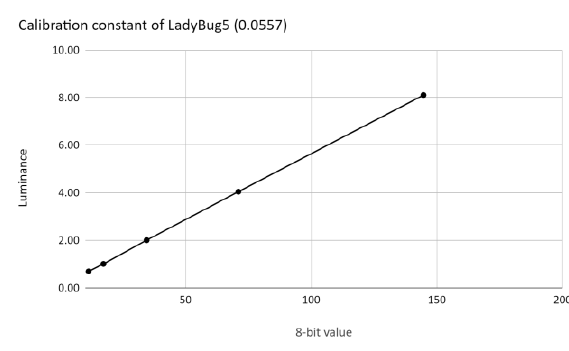
Figure 6. The illustration of LadyBug3 calibration constant. Luminance value in cdm -2 .